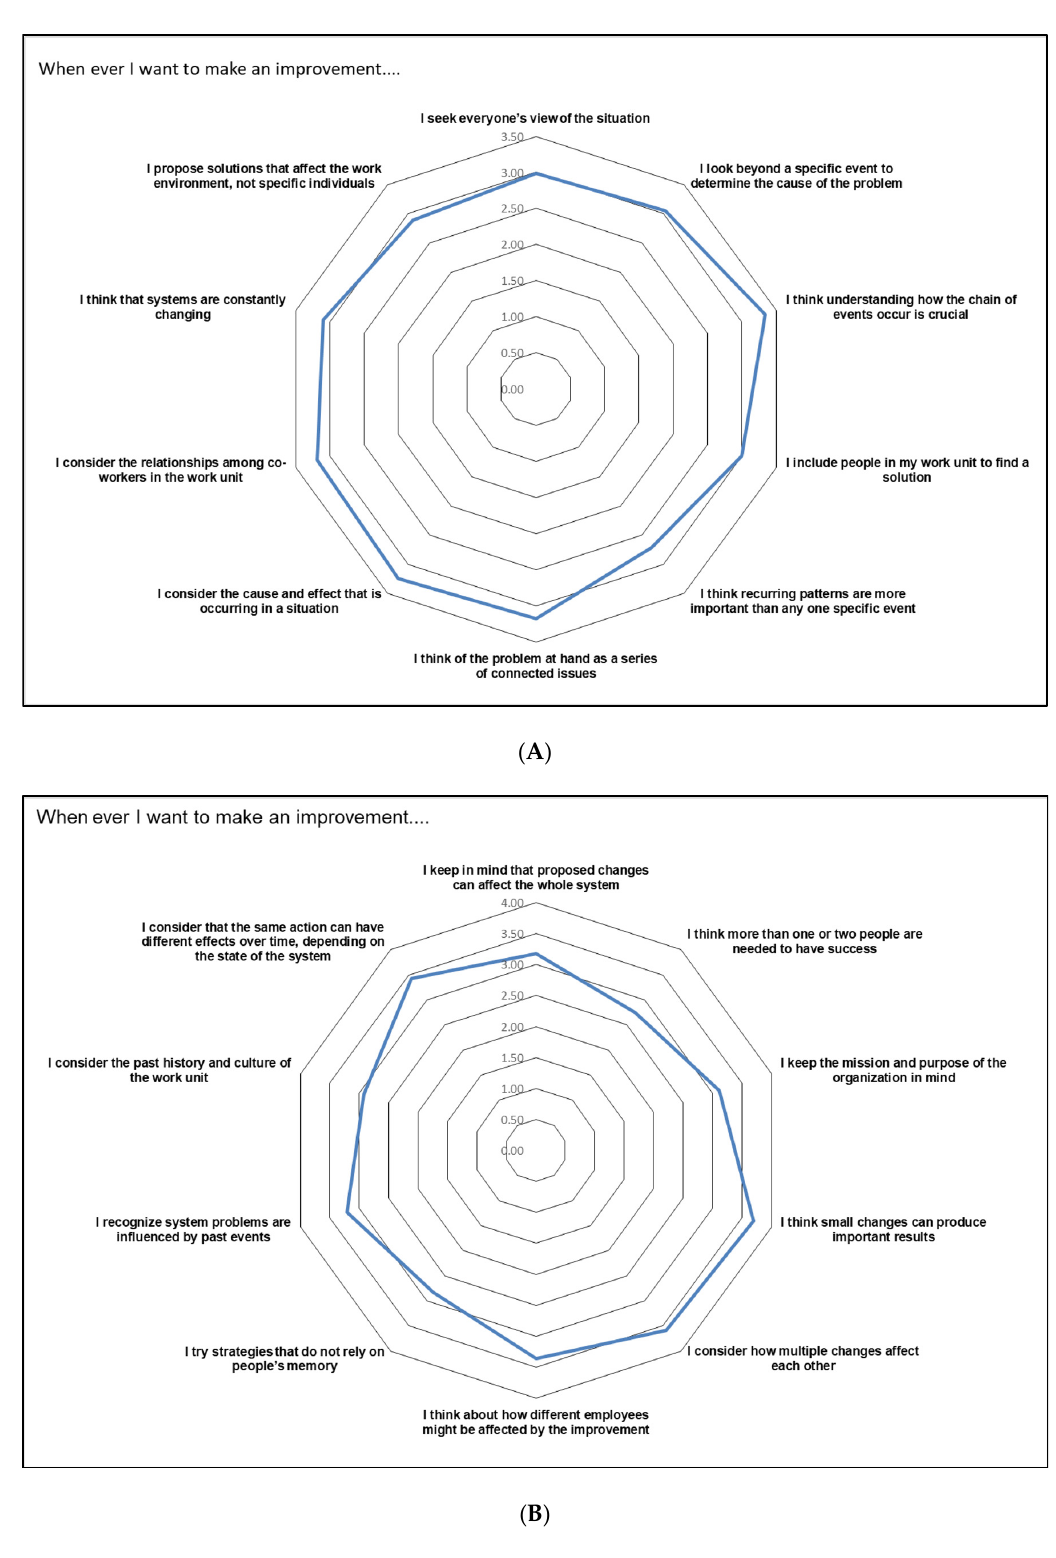
Figure 2. A graphical representation of the system thinking survey items with the most and least influential questions. ( A ), Part 1. ( B ), Part